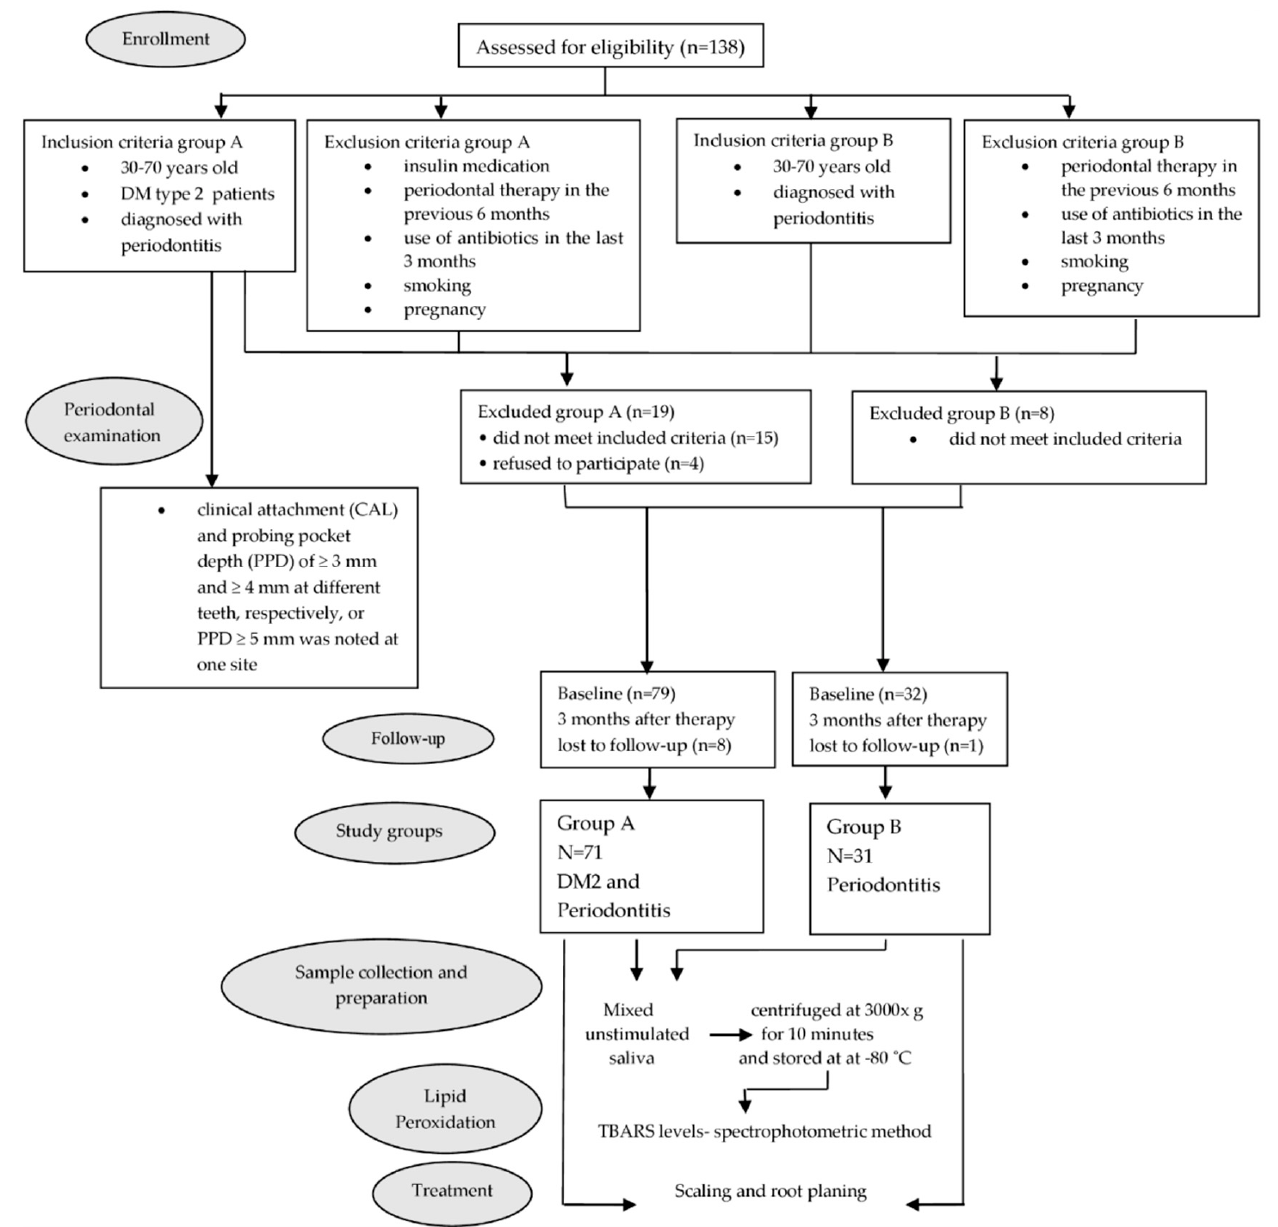
Figure 1. Flow chart of clinical study. Group A = DM2 participants; Group B = non-diabetic participants; TBARS-thiobarbituric acid reactive substance. This is a figure. Schemes follow the same formatting.